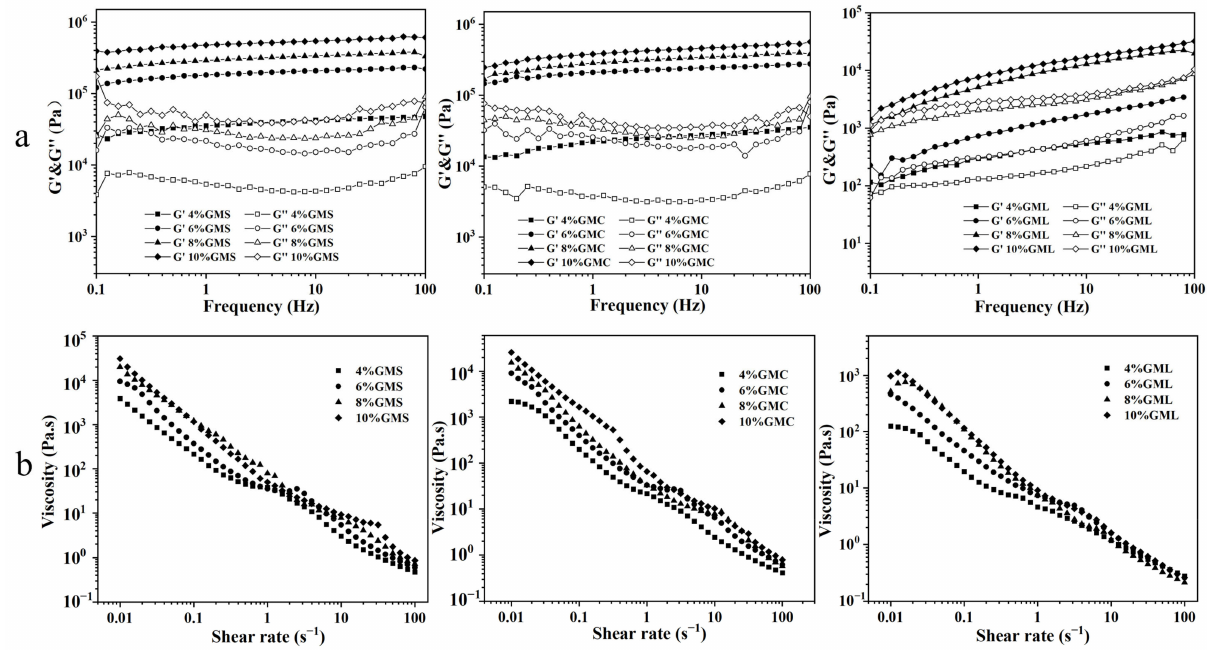
Figure 2. The behavior of the storage modulus (G (cid:48) ) and loss modulus (G (cid:48)(cid:48) ) in frequency sweep ( a ) and the shear-rate dependence of the viscosity of the oleogel samples ( b